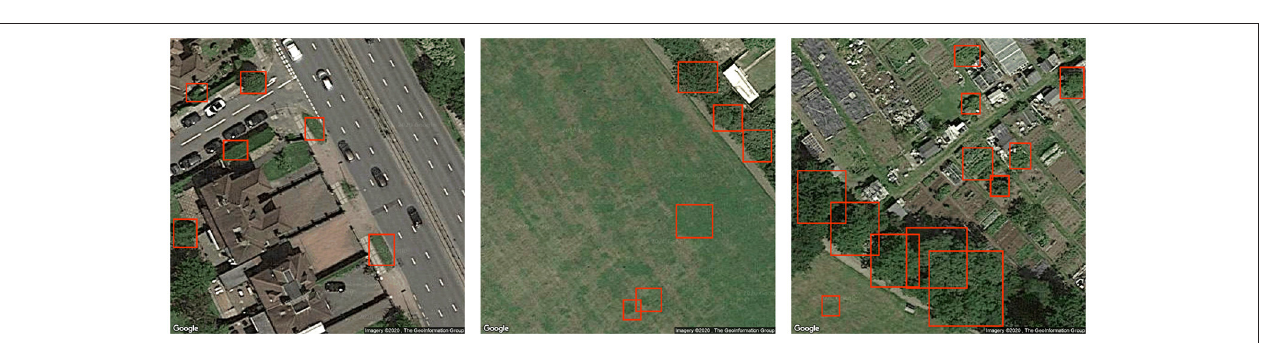
FIGURE 4 | Some examples of undesirable results with self supervised model (trees in red bounding